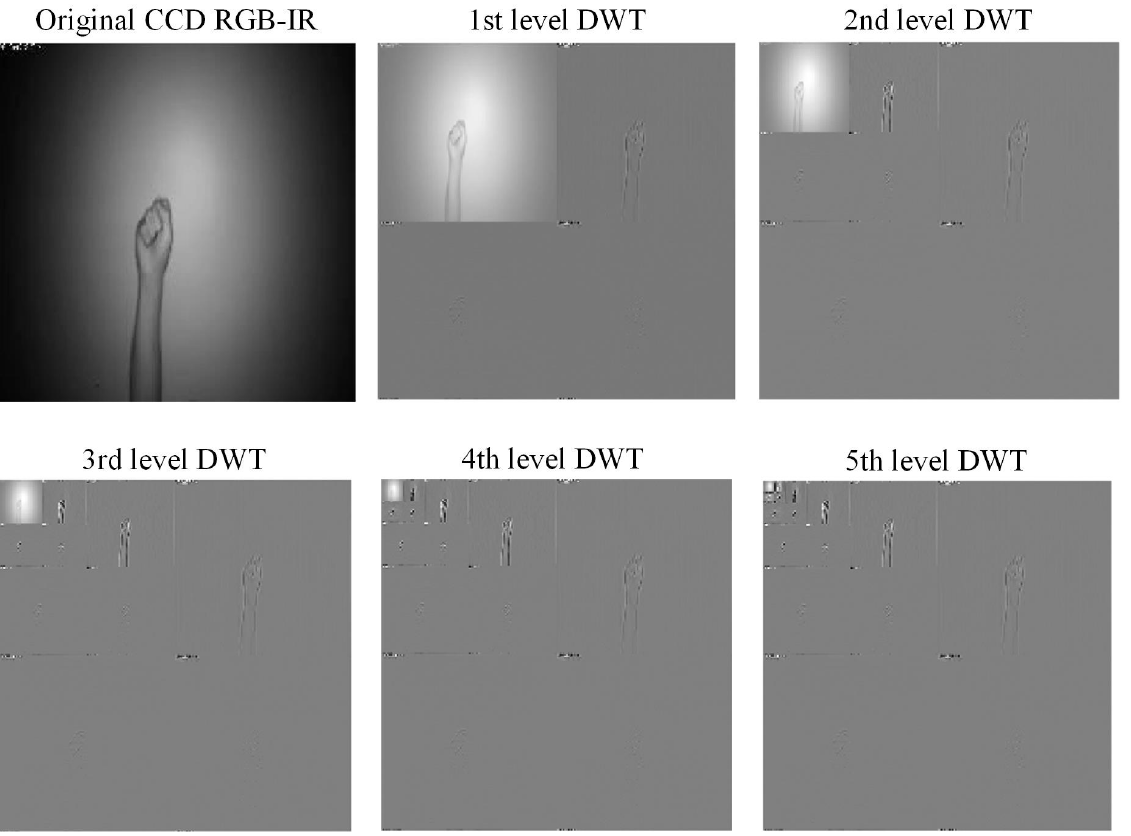
Figure 7. Coefficient derivation process of 5-level DWT decomposition on sensing data of the CCD RGB-IR modality of the hand gesture action.